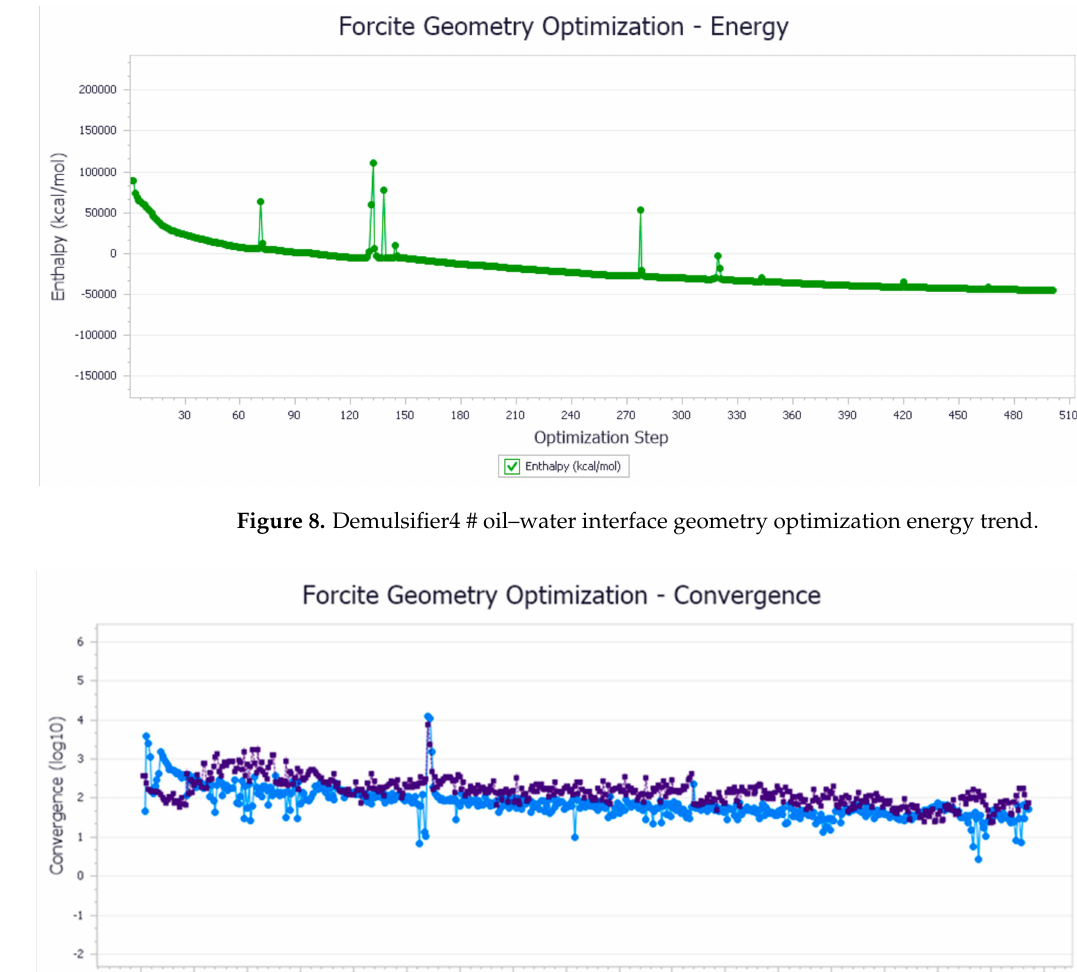
Figure 7. Demulsifier4 # oil–water interface geometric optimization steps.